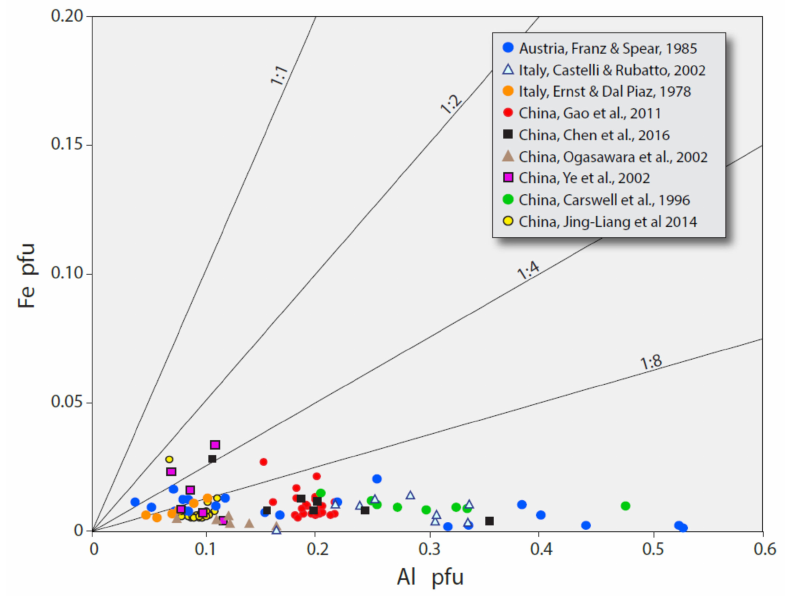
Figure 23. Fe versus Al in titanite from eclogites. Titanite grains from these rocks are typically more Al-rich and Fe-poor than any other genetic group. Data sources are shown on the